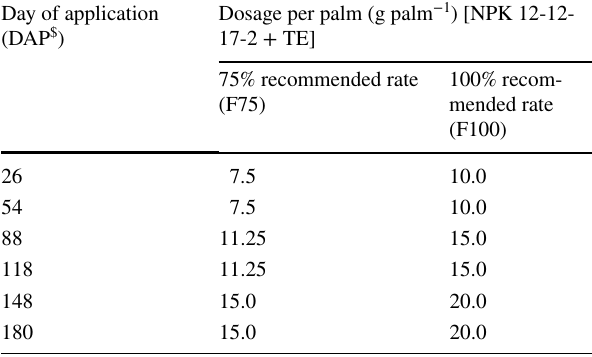
Table 2 Characterisation of soil and amendment used ( n = 4)